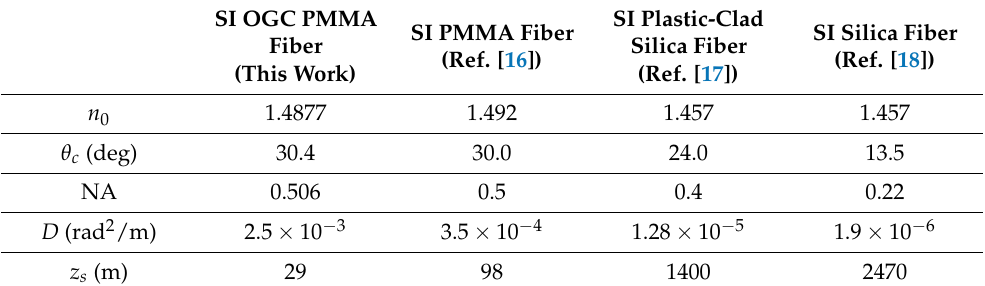
Table 1. Core refractive index n 0 , critical angle θ c , numerical aperture NA, coupling coefficient D , length z s at which SSD is achieved, for SI OGC PMMA fiber, SI PMMA fiber, SI plastic-clad silica fiber and SI silica fiber.